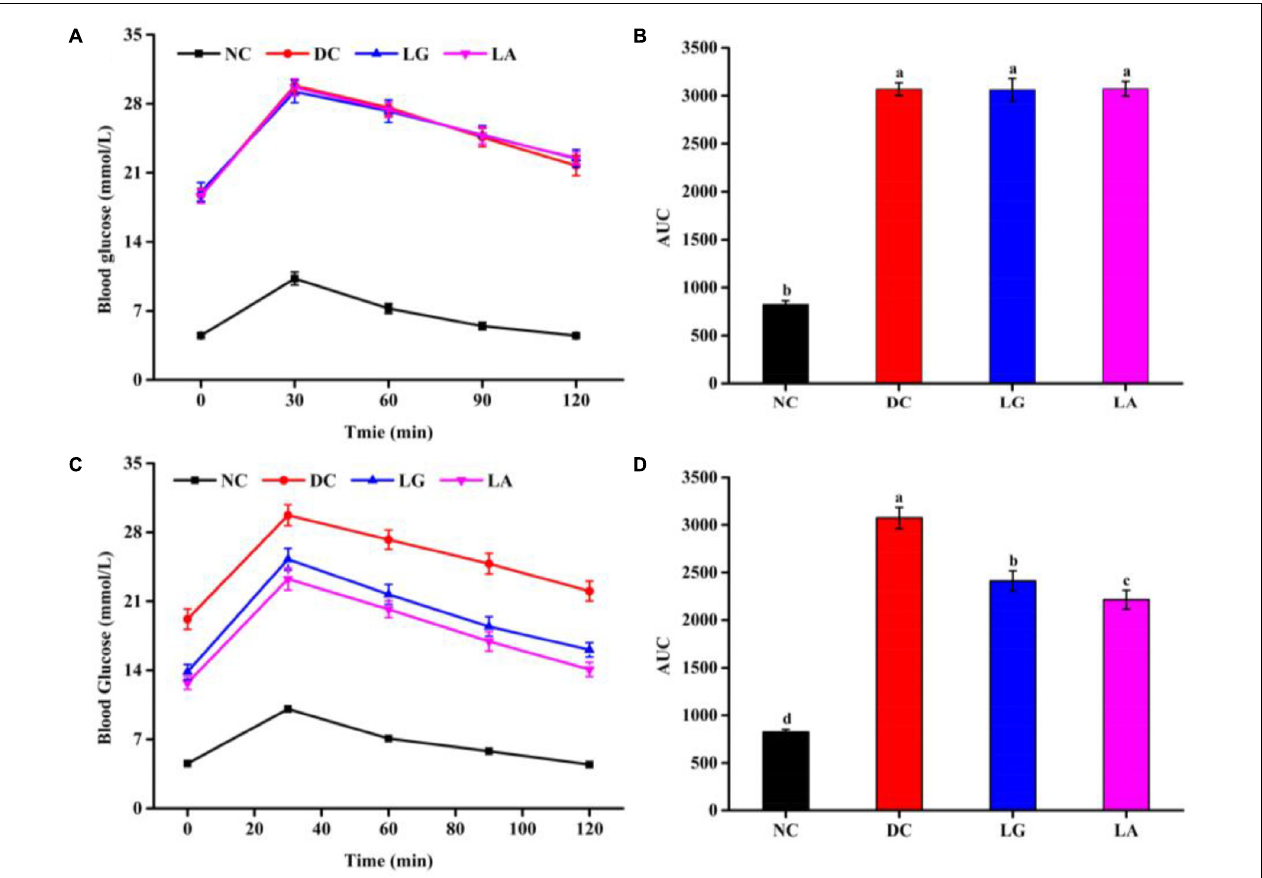
FIGURE 4 | The effect of probiotic treatments on oral glucose tolerance (OGTT) and AUC glucose at weeks 5 and 11. NC, normal control group; DC, diabetic control group; LG, DC plus L. rhamnosus GG; LA, DC plus L. acidophilus KLDS1.0901. (A) OGTT at week 5. (B) AUC glucose at week 5. (C) OGTT at week 11. (D) AUC glucose at week 11. All data are expressed as the mean ± SD ( n = 8 independent experiments). Groups without common letters differ significantly from one another ( p < 0.05).